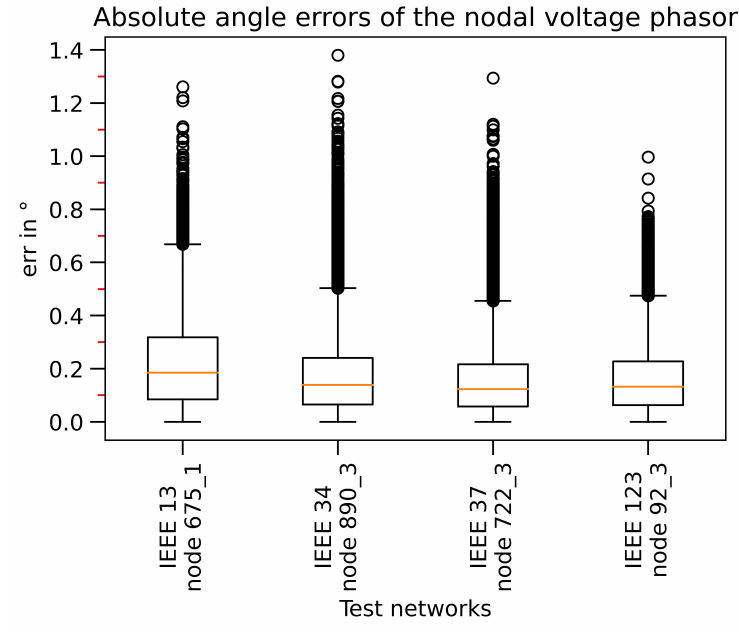
Figure 11. Distribution of absolute errors of nodal voltage phasor angles for nodes with the high- est